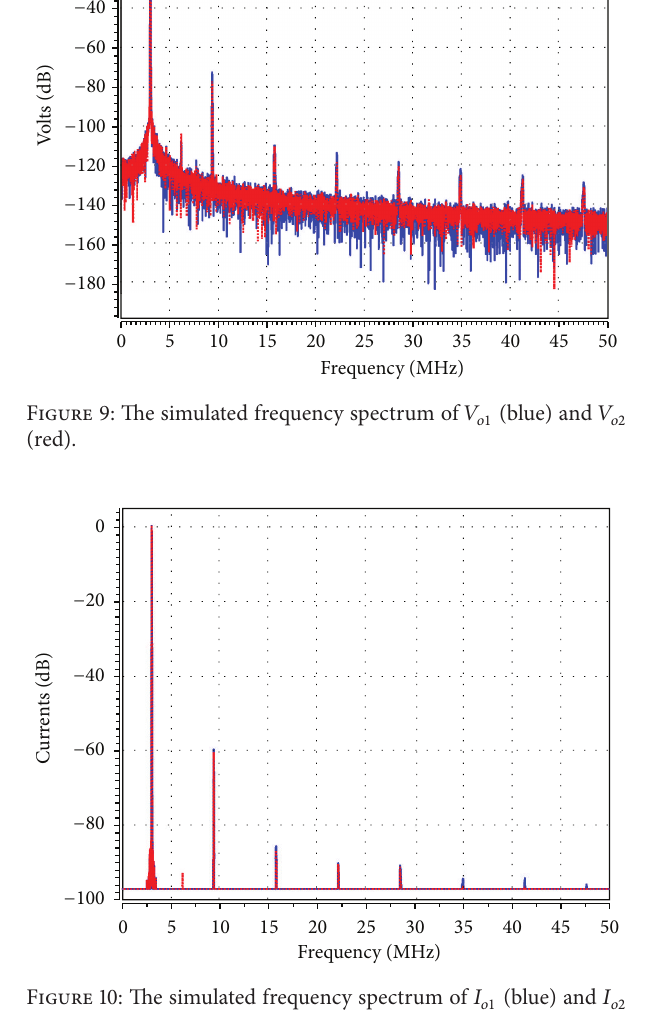
Figure 10: The simulated frequency spectrum of 𝐼 𝑜1 (blue) and 𝐼 𝑜2 (red).